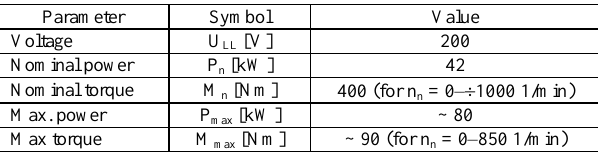
Fig. 2. The 3D model of the SMZs200S32 motor made by KOMEL [1] Table 1. Parameters of electric motor drive